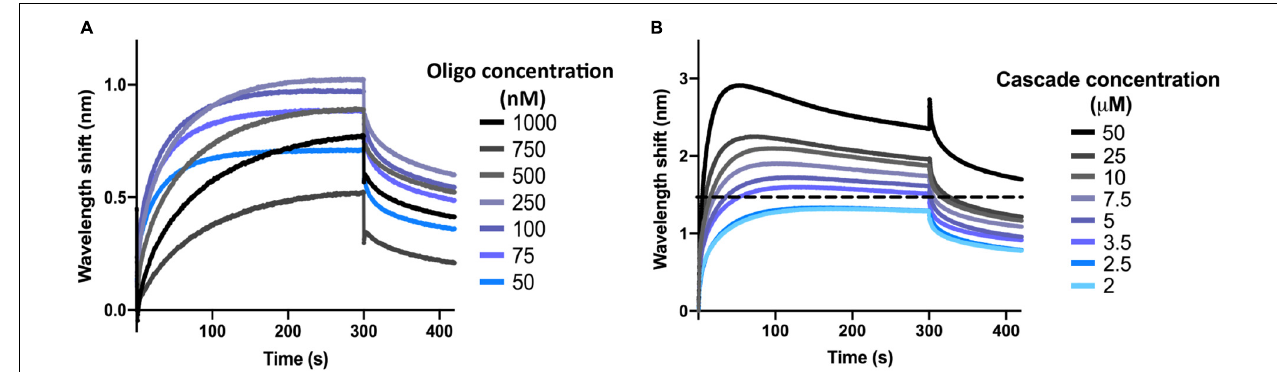
FIGURE 2 | Determination of optimal oligonucleotide concentrations and saturating protein concentrations. (A) The wavelength shift (nm) generated by the addition of 1 µ M Type I-Fv Cascade to different concentrations of complementary dsDNA oligonucleotide was recorded for 5 min. At an initial concentration of 100 nM of oligonucleotide, the reaction reached equilibrium (plateau) and produced the strongest signal. (B) Different concentrations of Type I-Fv Cascade were tested for binding to complementary dsDNA (immobilized at a concentration of 100 nM) for 5 min. The saturating concentration was established as the lowest concentration at which the binding curve reached a stable plateau (blue line). Higher concentrations did not further increase the wavelength shift at equilibrium or caused deviations from the expected binding behavior (as depicted above for 3.5 µ M by the dotted line).